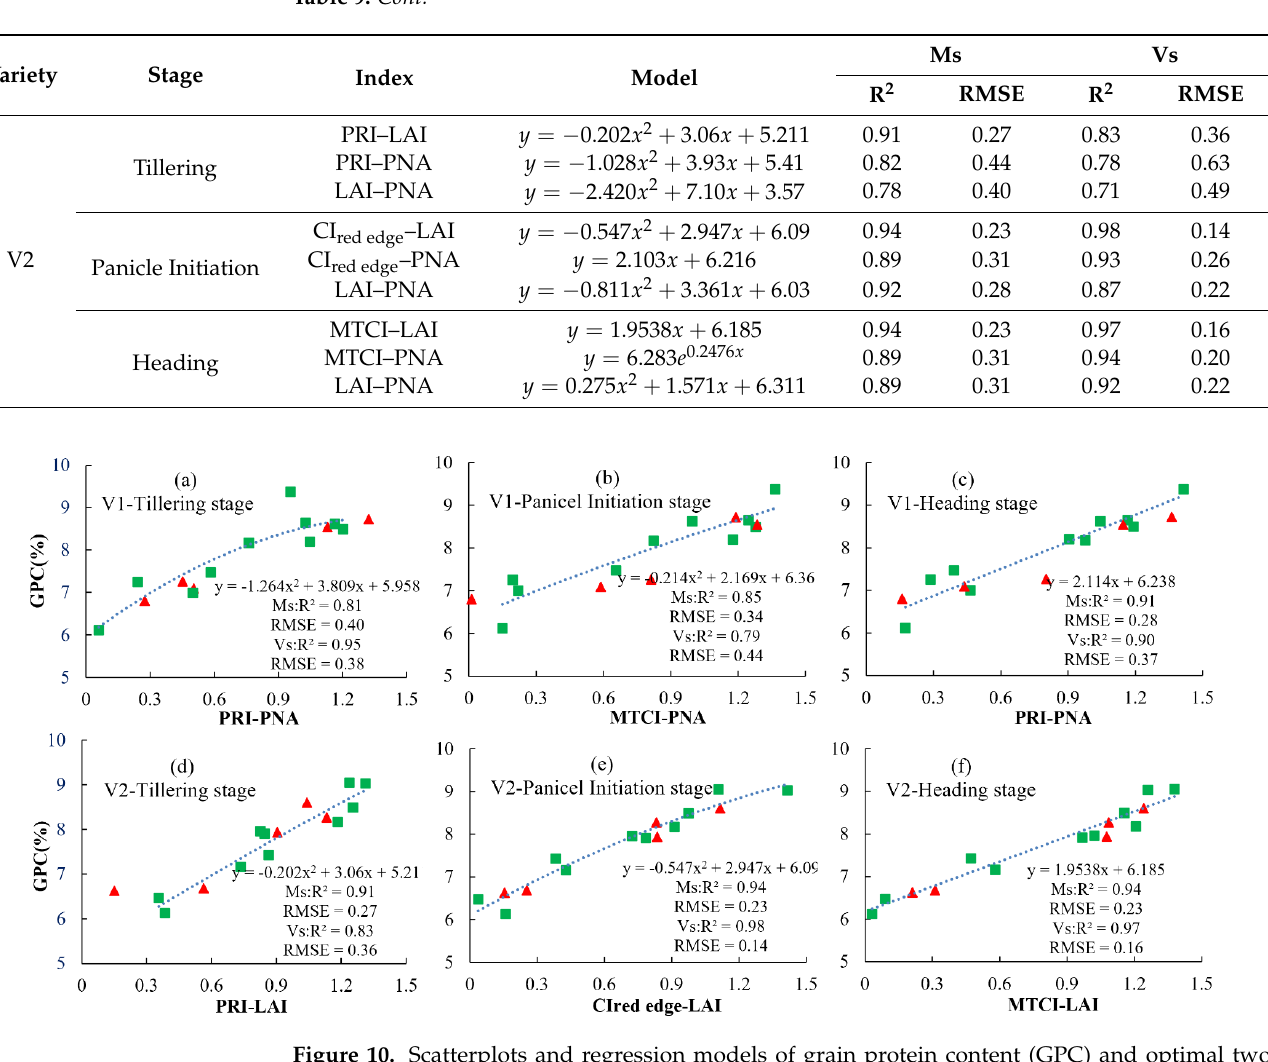
Figure 10. Scatterplots and regression models of grain protein content (GPC) and optimal two- dimensional monitoring indices for rice variety V1 (Meixiangzhan 2) at ( a ) the tillering stage, ( b ) pan- icle initiation stage, and ( c ) heading stage; and for variety V2 (Wufengyou 615) at ( d ) the tillering stage, ( e ) panicle initiation stage, and ( f ) heading stage.